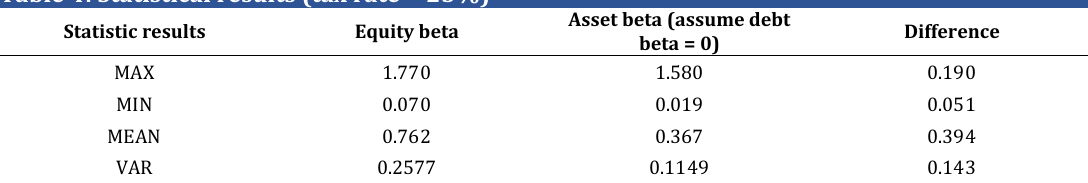
Table 4: Statistical results (tax rate = 25%)